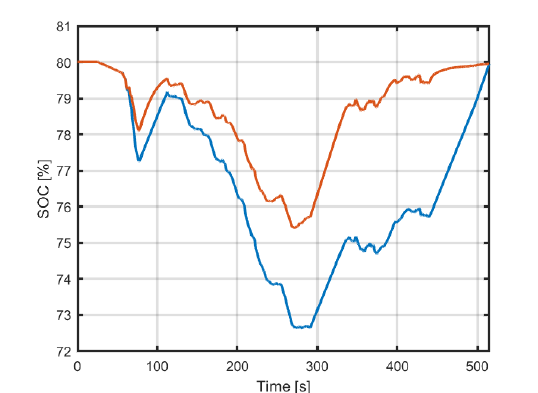
Figure 13: SOC of the battery with TCS - blue curve and PFCS - red curve